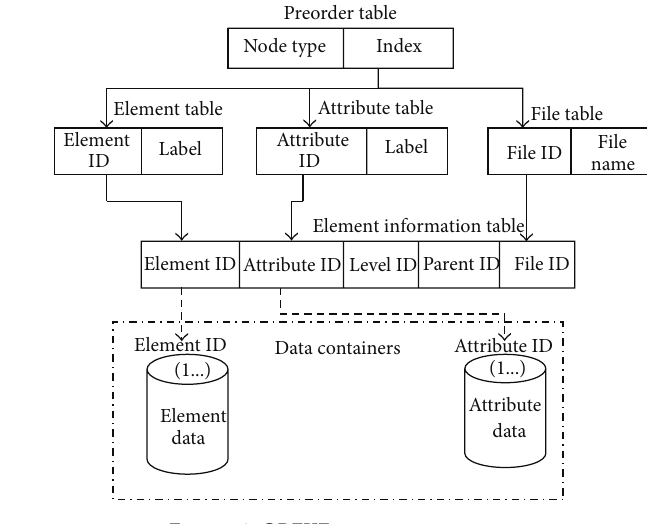
Figure 3: QRFXFreeze storage